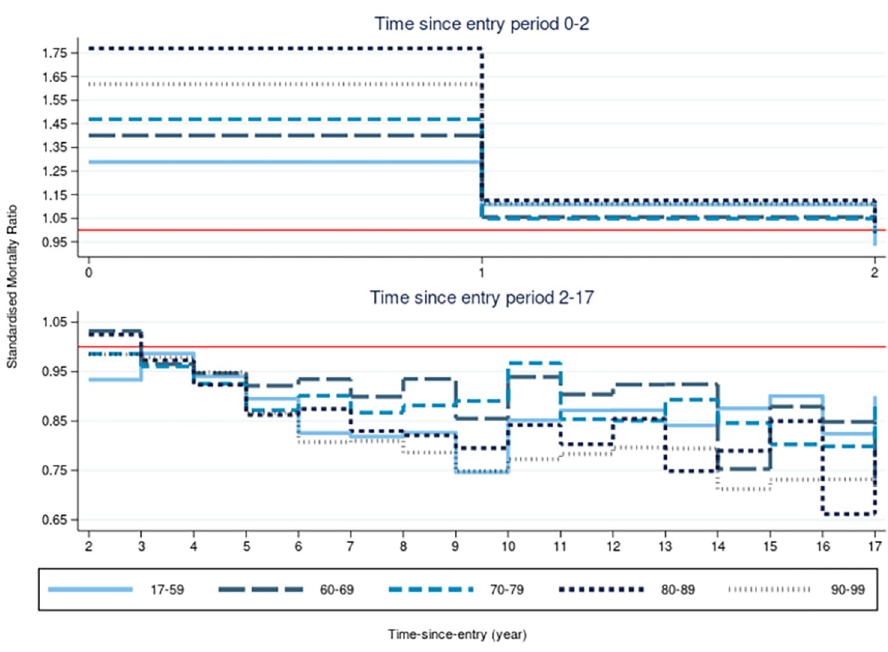
Fig 5. Standardised mortality ratio (SMR) by age group, over follow-up period in years. Split to show initial high mortality rate trend (5a) and lower mortality rate after year 2 (5b). Reference line of SMR = 1 in